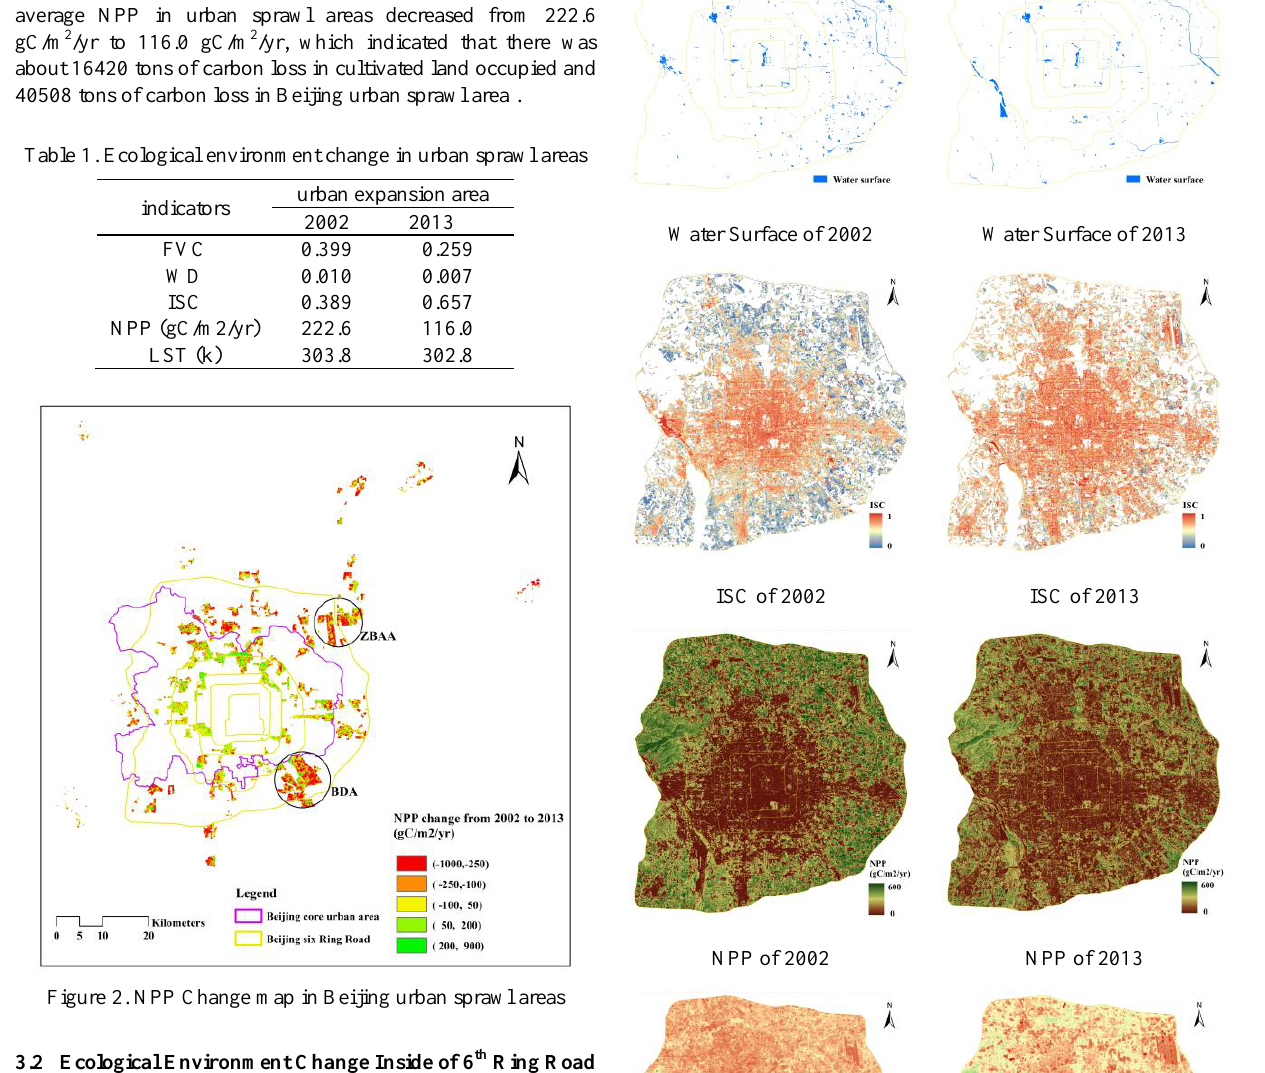
(Table 1). Among of them, NPP decreased most seriously. NPP even decreased more than 250gC/m 2 /yr in Beijing Economic- Technological Development Area (BDA) and Beijing-Capital International Airport (ZBAA) (Figure 2). From 2002 to 2013, average NPP in urban sprawl areas decreased from 222.6